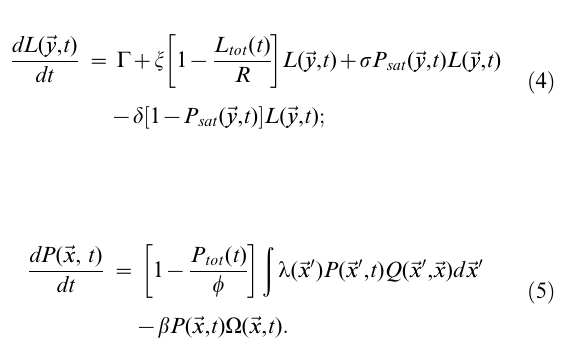
Figure 1. Coevolving shape space distributions of pathogen and T-cell populations over 900 days of infection. The infection shown is an example of a stochastic mutating infection. Inset A (days 0– 50) highlights the early periodic bursts of pathogen mutation which lead to chronic infection rather than clearance, driven by peaks in pathogen density which are subsequently controlled by the immune response. Insets B and C (days 50–500) provide a closer look at the chronic phase, which exhibits wave-like pathogen dynamics, pathogen speciation driven by the interaction with the immune response, and a resulting branch in T-cells, which is caused by selection alone. Following more branching, increased homeostatic pressure on the T-cells leads to the pathogens’ dramatic escape from immune control (around day 870), marked by sudden rapid proliferation and unchecked diffusion throughout shape space. In this simulation, l ~ 3 : 3 day { 1 , b ~ 10 sites